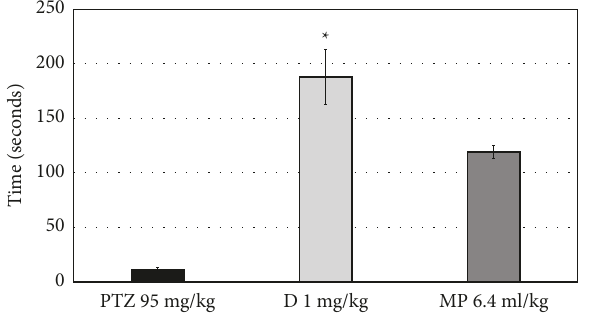
Figure 7: Effects of MPO (6.4ml/kg) on the latency to death in PTZ-induced epilepsy model in mice, ∗ P < 0 . 5 when compared to the PTZ group. PTZ: pentylenetetrazol, D: diazepam, MP: Mentha piperita L . insignificantly ( P � 0 . 993), as presented in Figure 5. Figure 6 shows that MPO did not significantly reduce the number of convulsions ( P � 0 . 967). Furthermore, MPO (at a high dose) increased the latency to death in the PTZ-induced group, but only marginally ( P � 0 . 195) (Figure 7).